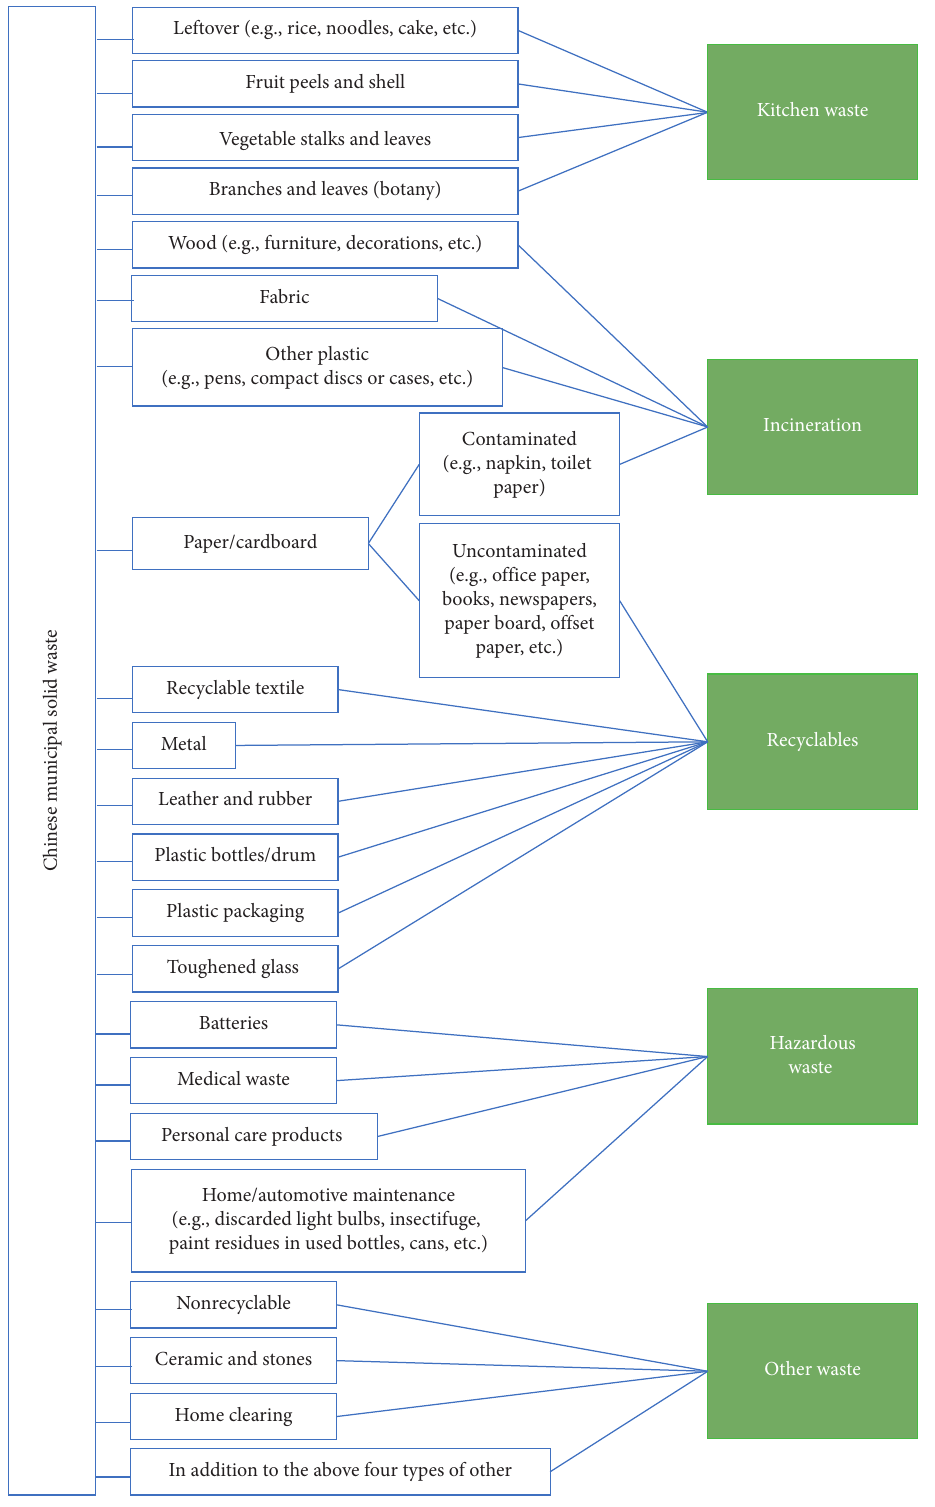
Figure 2: Proposed MSW